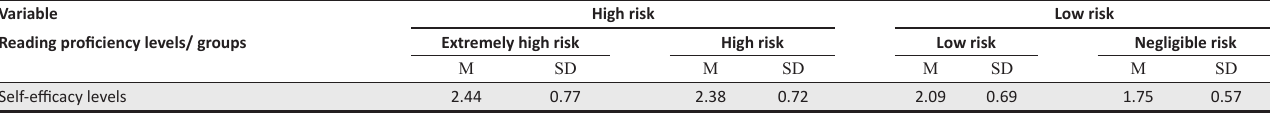
TABLE 2: Means and Standard Deviations for students’ self-efficacy levels in relation to their reading proficiency. Variable High risk Reading proficiency levels/